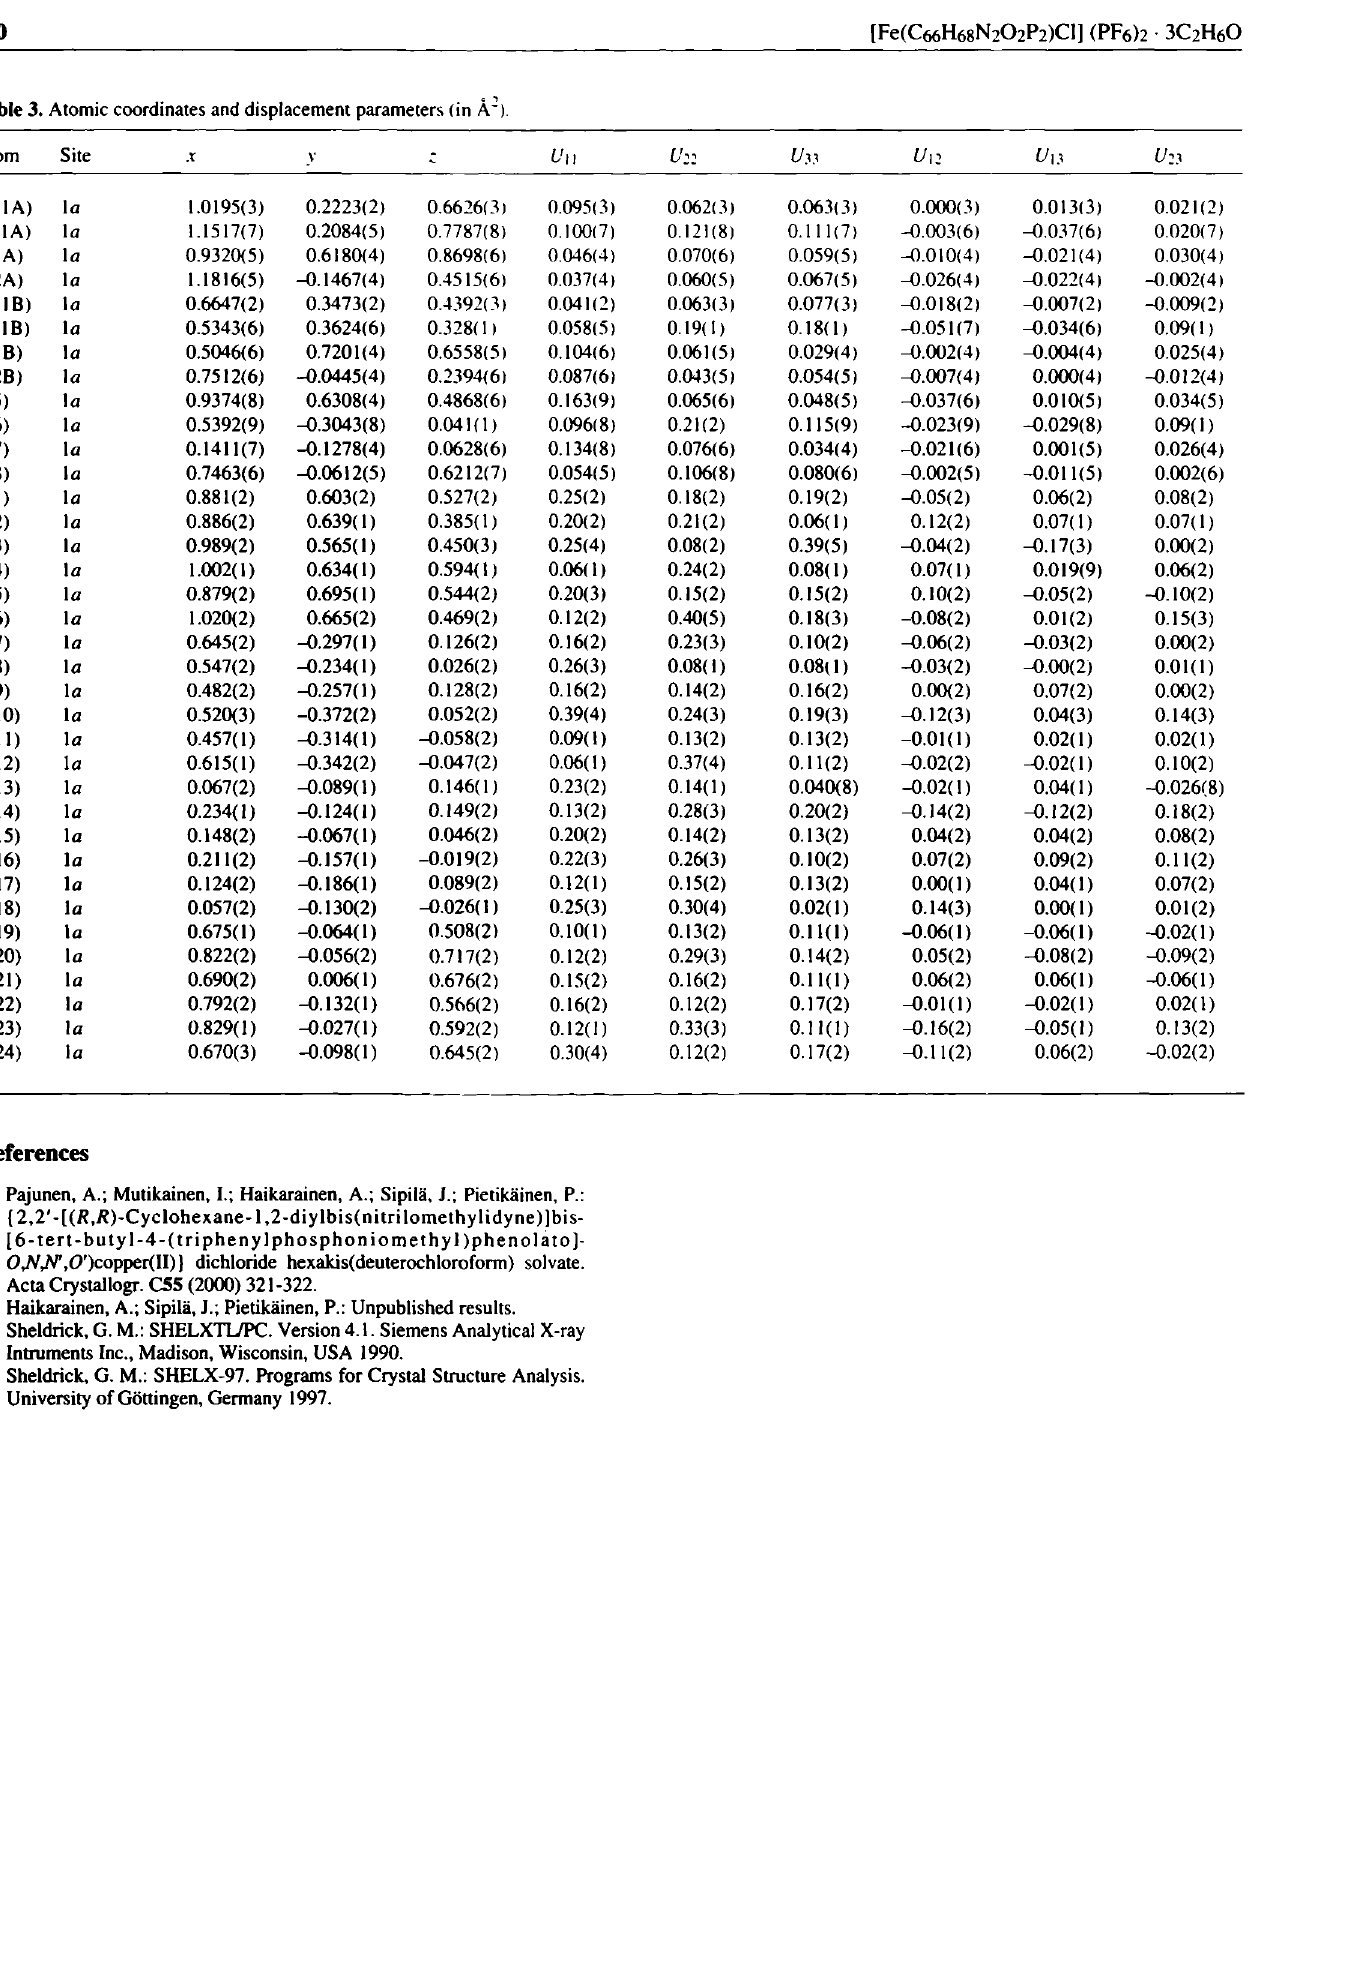
Table 3. Atomic coordinates and displacement parameters (in